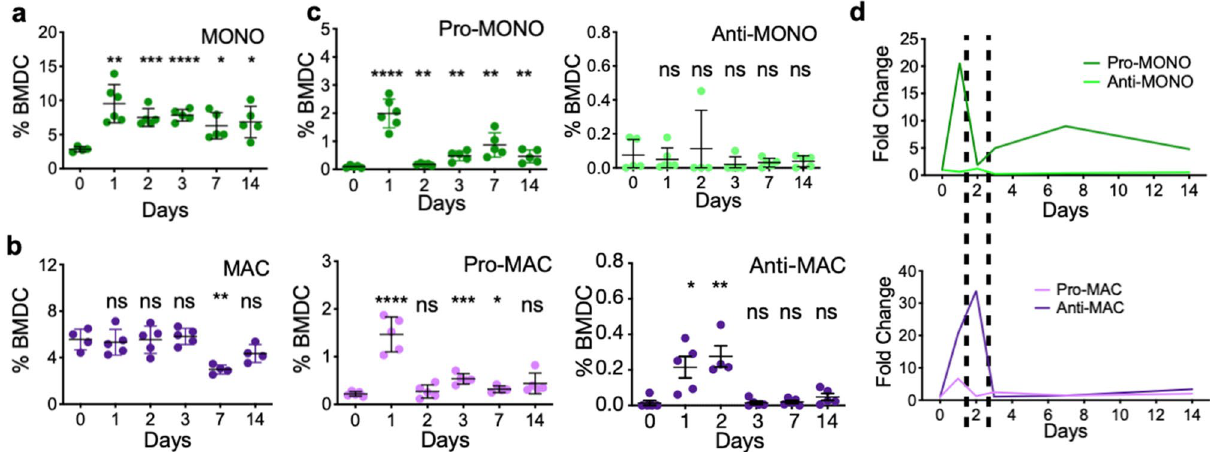
Figure 3. Transient waves of pro- and anti-inflammatory monocytes and macrophages alternate dynamically during bone injury repair. Flow cytometry performed on tibia bone marrow harvested from C57BL/6 mice at various time points after injury (n = 30; 5/time point) reveals diverse myeloid dynamics and polarization. Time points corresponds to time points from histological data. Total monocyte (CD11b + LY-6C HI LY-6G-; ( a ) and macrophage (CD11b + LY-6C LO LY-6G-; ( b ) and their respective pro- and anti-inflammatory subsets ( c ) each uniquely fluctuates following bone injury (Student t-test compares all time points to its Day 0 for each subset; * p < 0.05 ** p < 0.005 *** p < 0.0005 **** p < 0.00005 ns p > 0.05). ( d ) Temporal dynamics of pro and anti-inflammatory monocytes and macrophage numbers are normalized as fold change relative to levels at homeostasis. Dashed lines show timings of pro- and anti-inflammatory polarization are mutually (Fig. 2) and asked how would osteoclast activity change overtime in order to fit to the bone data. In this agnostic approach, we no longer restricted osteoclast resorption to constant rates over time, but defined a piecewise linear function of time for osteoclast resorption rate (Supplemental Fig. 7a and b, Mathematical and Computational Methods). Independent of the parameters chosen for the initial piecewise slope conditions, the optimization algorithm identified a functional form composed of two waves: initially intense and transient between days 1 and 2, followed by a milder but persistent wave starting after Day 3 (Supplemental Fig. 7c; orange line). We noted this temporal profile was very similar to that of experimental data regarding the pro-inflammatory monocytes and macrophages populations (Fig. 3c and Supplemental Fig. 7c). While this result does not discount the pos- sible contribution from other cells within the bone marrow, it does further supports that pro-inflammatory cells contribute significantly to osteoclast behavior and therefore bone healing dynamics (Supplemental Fig. 7). We used a similar approach to determine variable osteoblast activity and defined a piecewise linear function of time, for the bone formation rate (Supplemental Fig. 8a). Interestingly, this model did not recapitulate bone volume